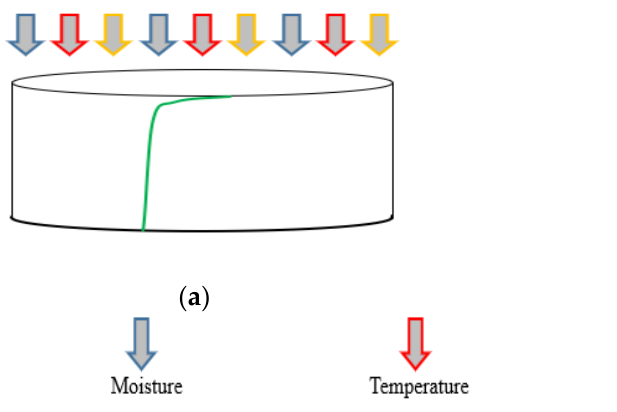
Figure 3. Schematic illustration of asphalt aged in the ( a ) field and ( b ) oven.